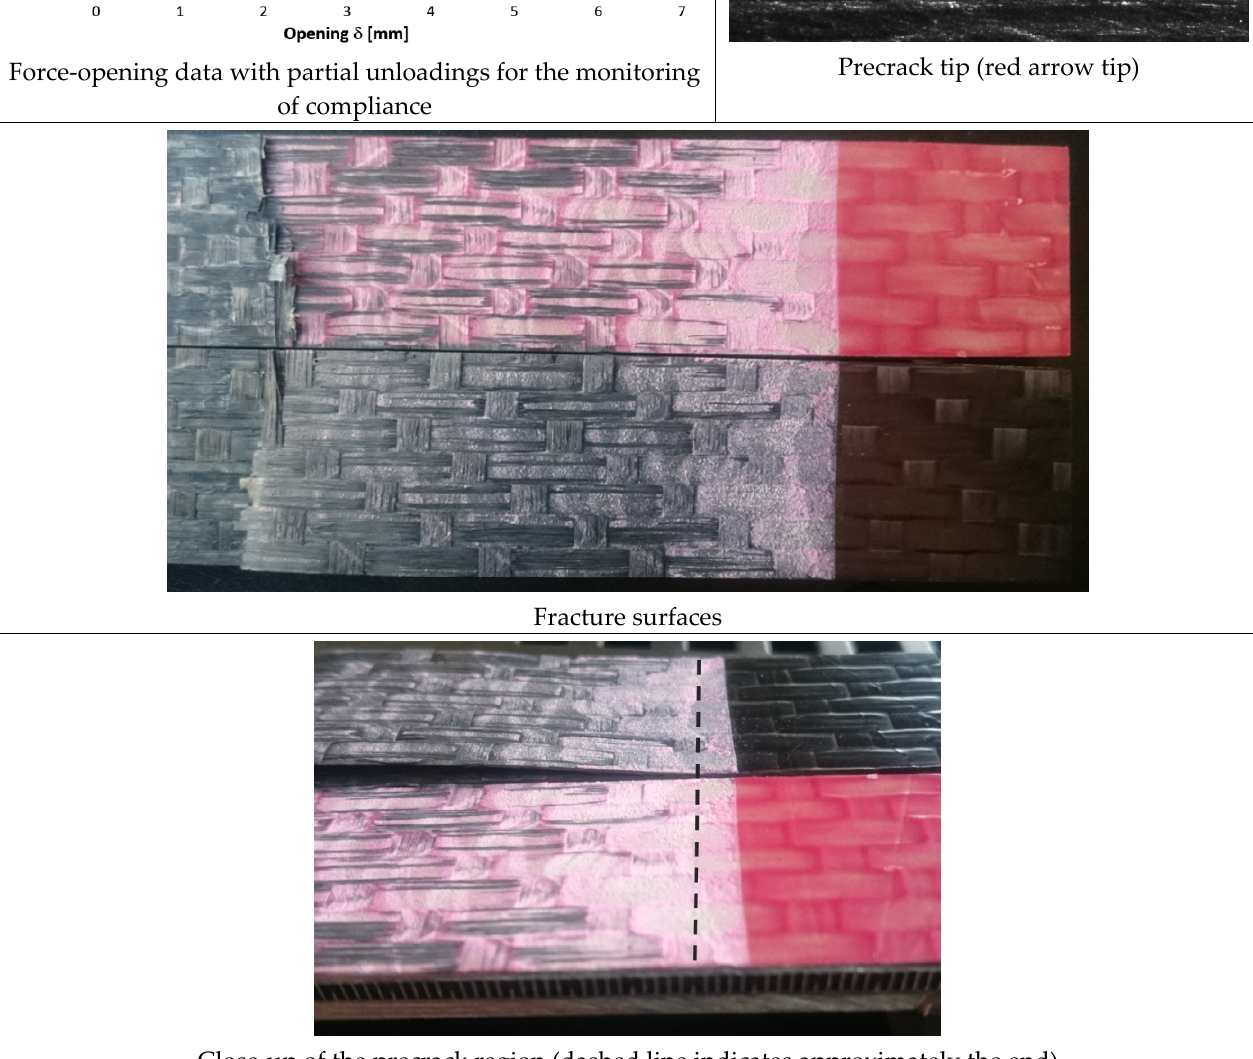
Figure 14. Results of the test on specimen DCB_AF163_01.